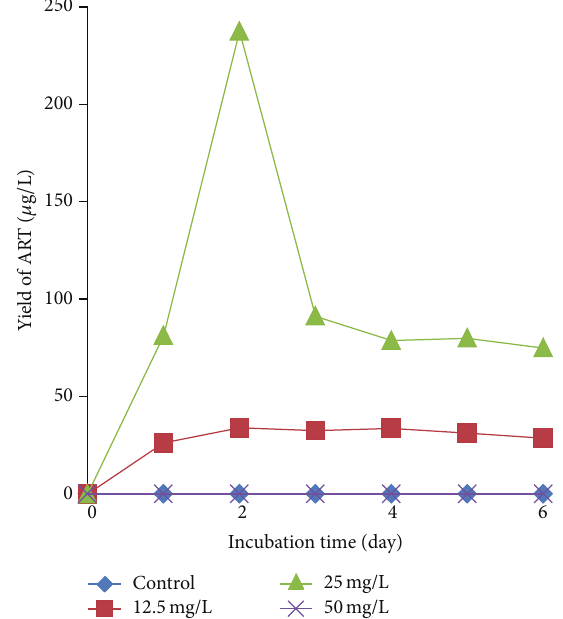
Figure 4: Effect of DHAA on the yield of ART.